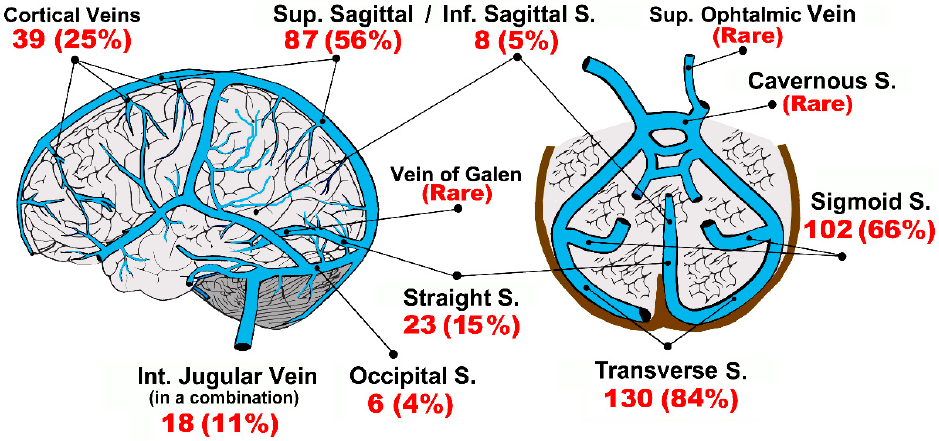
Figure 3. Representation of the anatomy of cerebral veins, site(s) and rates of thrombus formation ( n = 155 patients). Most patients were found to have clots in more than a single vessel. Abbreviations,